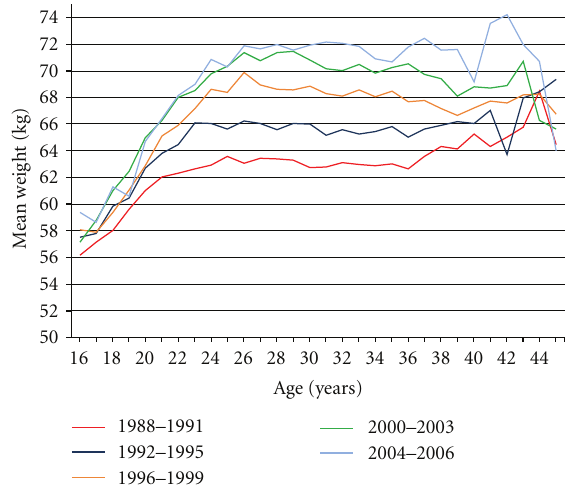
Figure 3: Change in maternal prepregnancy bodyweight by year of age and time period, age 16 to 45